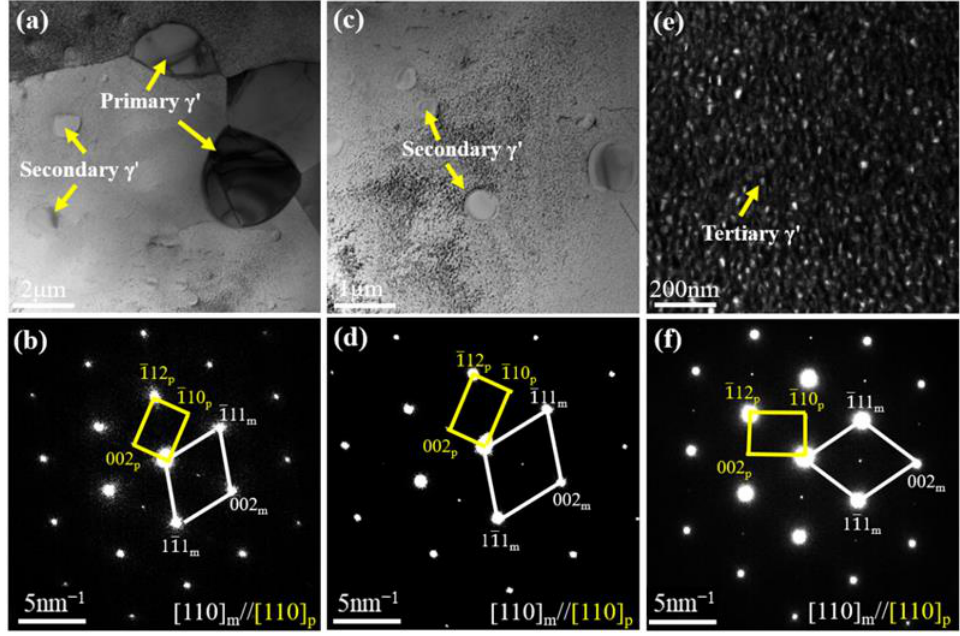
Figure 3. TEM micrographs of the heat-treated superalloy: ( a , c , e ) are the primary, secondary, and tertiary γ′ precipitates, respectively; ( b , d , f ) are their corresponding SAED patterns, respectively. By calibrating the super diffraction spots and the matrix diffraction spots, the orienta- tion relationships between the precipitates and the matrix can be obtained as follows (m represents matrix, p represents γ (cid:48)